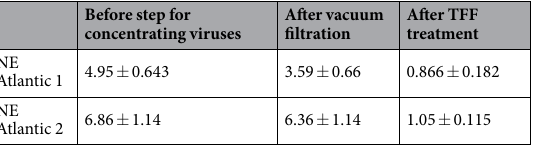
Table 2. Comparison among the abundances of viruses extracted from sediments by means of the PC procedure before and after vacuum filtration and TFF treatment. All data are expressed as 10 8 virus g − 1